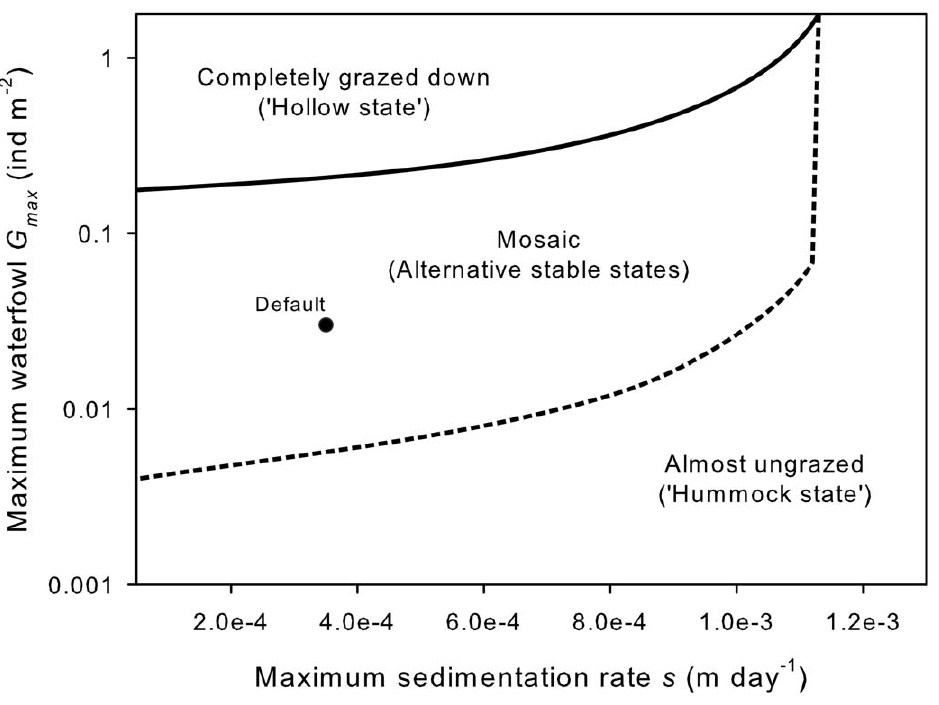
Figure 4. A two-dimensional bifurcation analyses of the maximum sedimentation rate s and the maximum number of waterfowl G max (on a log-scale) in the non-spatial version of the model demonstrates that landscape mosaics can appear over a wide range of parameter settings. The solid line indicates the threshold between a mosaic state and the conditions where seagrass is completely grazed down in autumn. A state with an elevated bed level and low grazing is the only possible state below and right of the dashed line. Default parameter settings are indicated by the black dot. The effect of sedimentation rate was analysed in the range of 0.05 to 1.13 mm day 2 1 , bird densities were tested in the range of 0.001 to 2 ind m 2 2 . Note that formation of mosaics is not possible in the absence of sedimentation and/or birds.